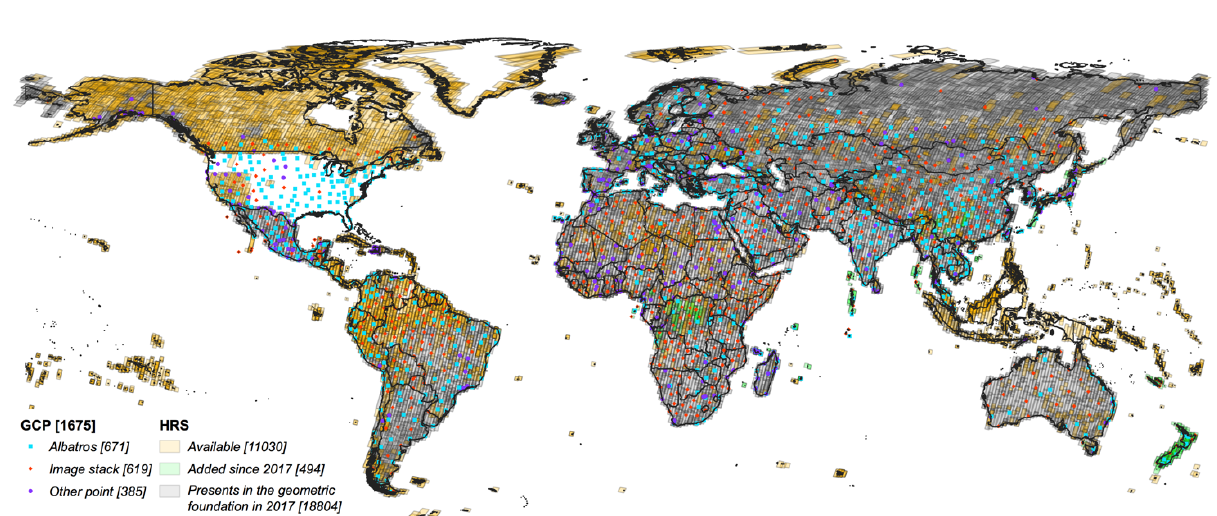
Figure 10. Geometric foundation – January, 2020